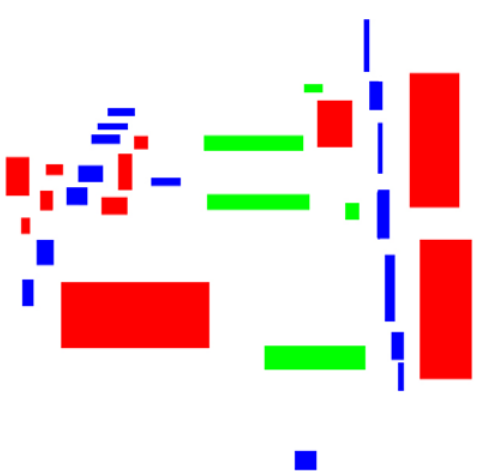
Figure 2. Initial segmentation result at scale 0